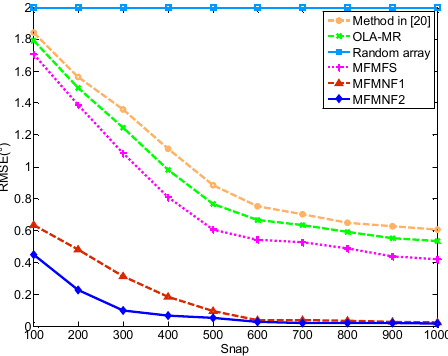
Figure 4. RMSEs versus the number of snapshots.